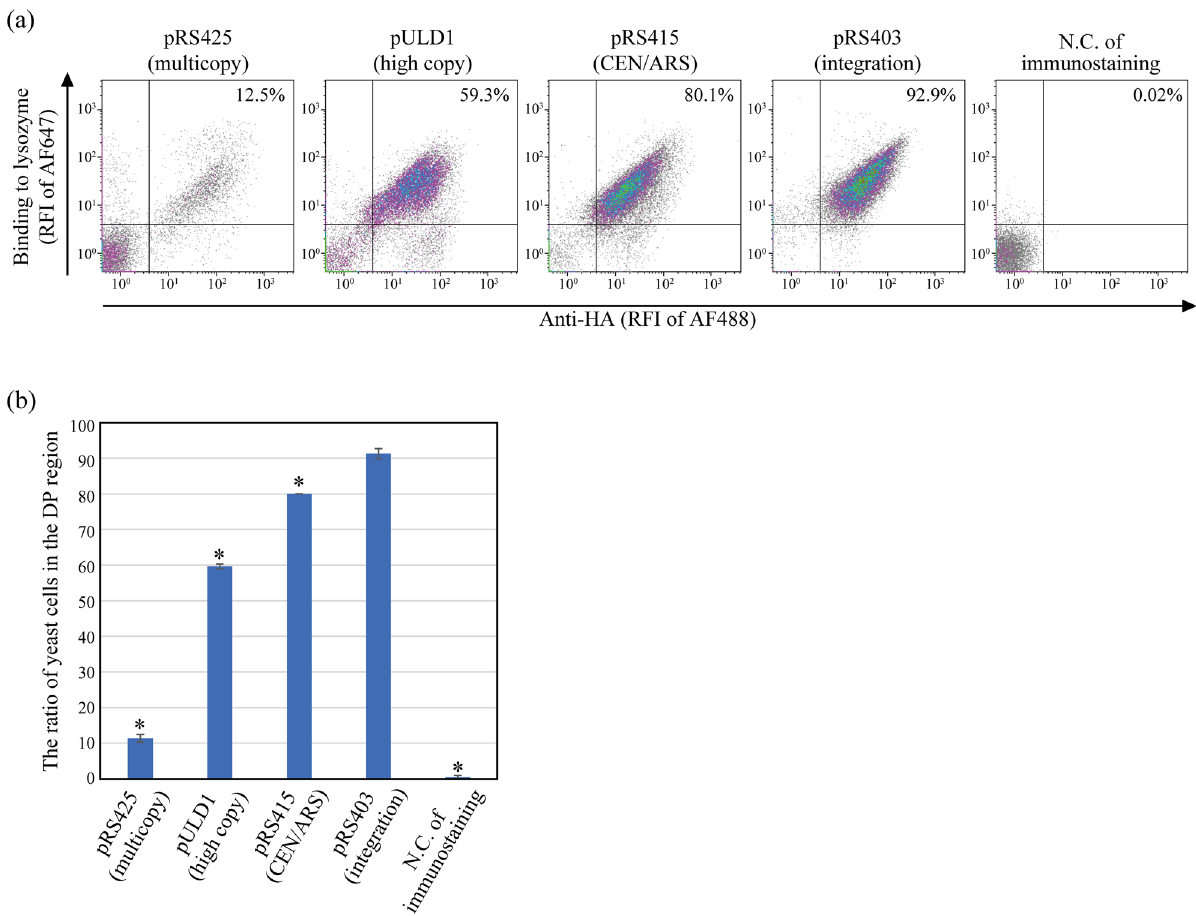
Figure 2. Improving of display efficiency by selecting an optimal vector to produce the SpyCatcher- anchor protein. The vector for the negative control yeast, used to indicate nonspecific absorption during immunostaining and flow cytometry, did not contain a nanobody-encoding sequence nor an HA tag; instead, it contained a FLAG tag. Each sample was stained with mouse anti-HA tag antibody, AF488-conjugated anti- mouse antibody and AF647-labelled lysozyme. (a) Density plots of the flow cytometry analysis. The ratio of yeast cells is shown in the upper right (UR) corner of each graph. The data shown are representative of three independent experiments. (b) Comparison of the double-positive (DP) regions represent yeast cells with strong AF488 and AF647 signals. The data from three independent experiments were represented as means ± standard deviations. Dunnett’s test was used to compare the display efficiency of the pRS403 strain to other strains (* p < 0.005). This figure was created using Illustrator CS2 (https:// www. adobe.